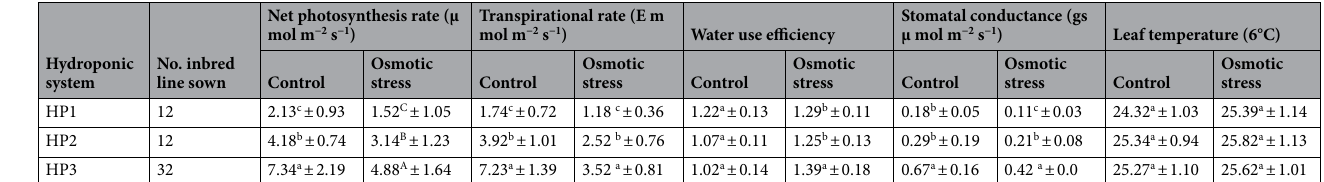
Table 2. Response of the sunflower germplasms for leaf gas exchange parameters under control and osmotic stress treatment in the hydroponic systems. HP1 = Hydroponic platform with roots directly submerged in nutrient media; HP2 = Two staged with gravel anchoring substrate, HP3 = Two staged with glass beads anchoring